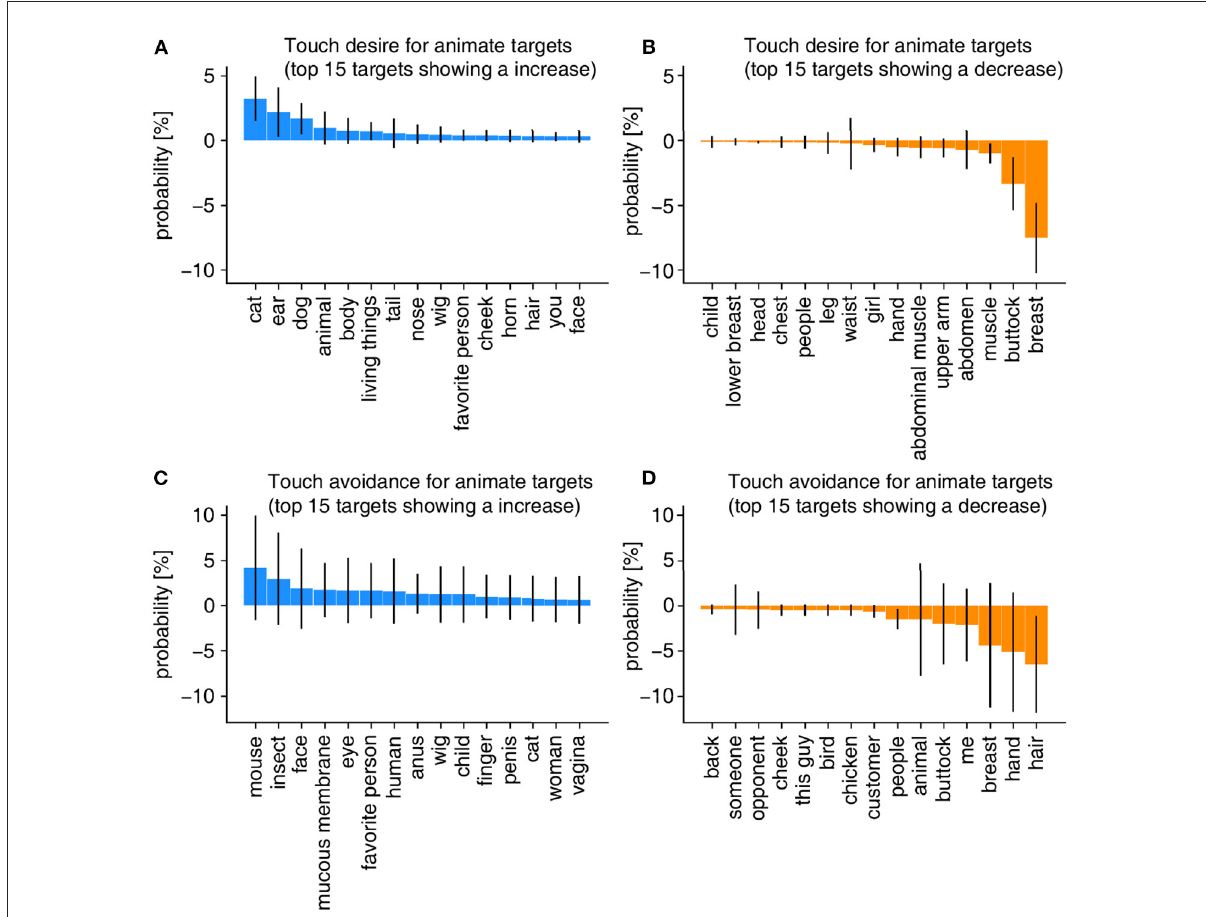
FIGURE6 The difference in probability distributions for the top 15 and bottom 15 targets that exhibited a significant difference between the period before the outbreak and the period showing a significant change in the analysis of DID (Figure 5) are shown. (A,B) Touch desire for animate targets during 1st wave in 2020. (C,D) Touch avoidance for animate targets at 3rd wave period in 2020. The blue bars indicate the increased probability and the orange bars indicate the decreased probability. For each target, the calculated 95% CI with Bonferroni correction with bootstrap samples are shown in the